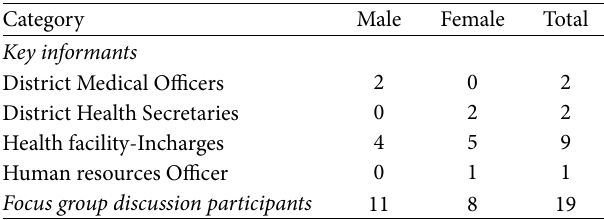
Table 2: Participants for KIIs and